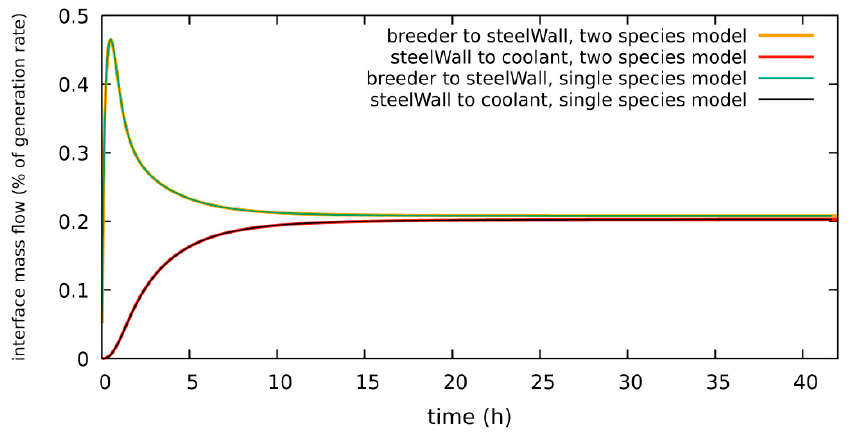
Figure 17. Transient tritium flow through patch interfaces breeder to and from steel, and steel to and from coolant for surface-limited conditions. The results of the single- and two-species models obviously